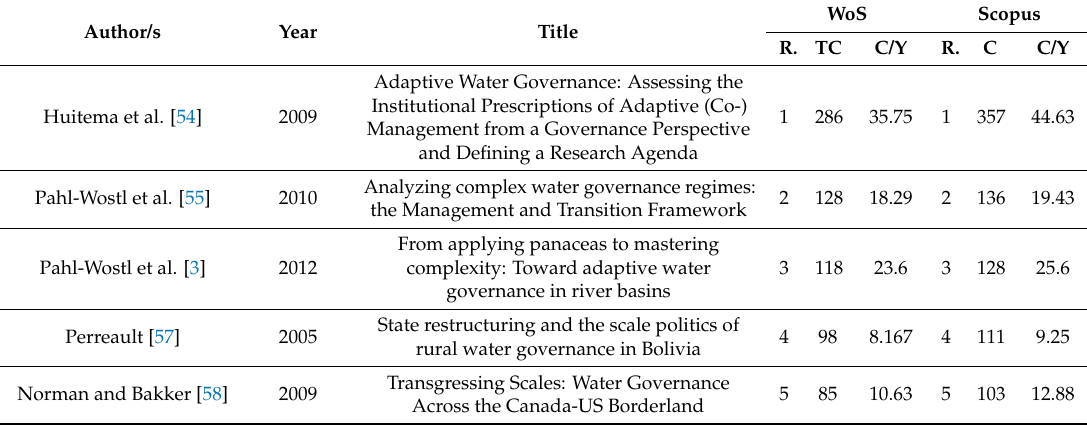
Table 2. Most relevant articles according to the criterion number of